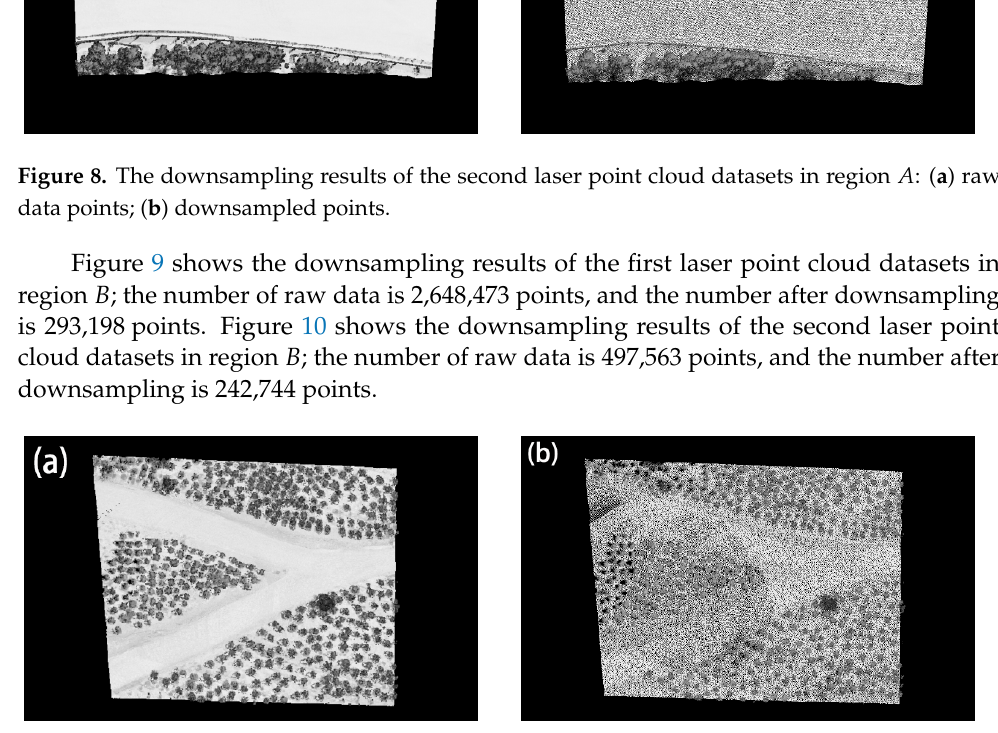
Figure 9. The downsampling results of the first laser point cloud datasets in region B : ( a ) raw data points; ( b ) downsampled